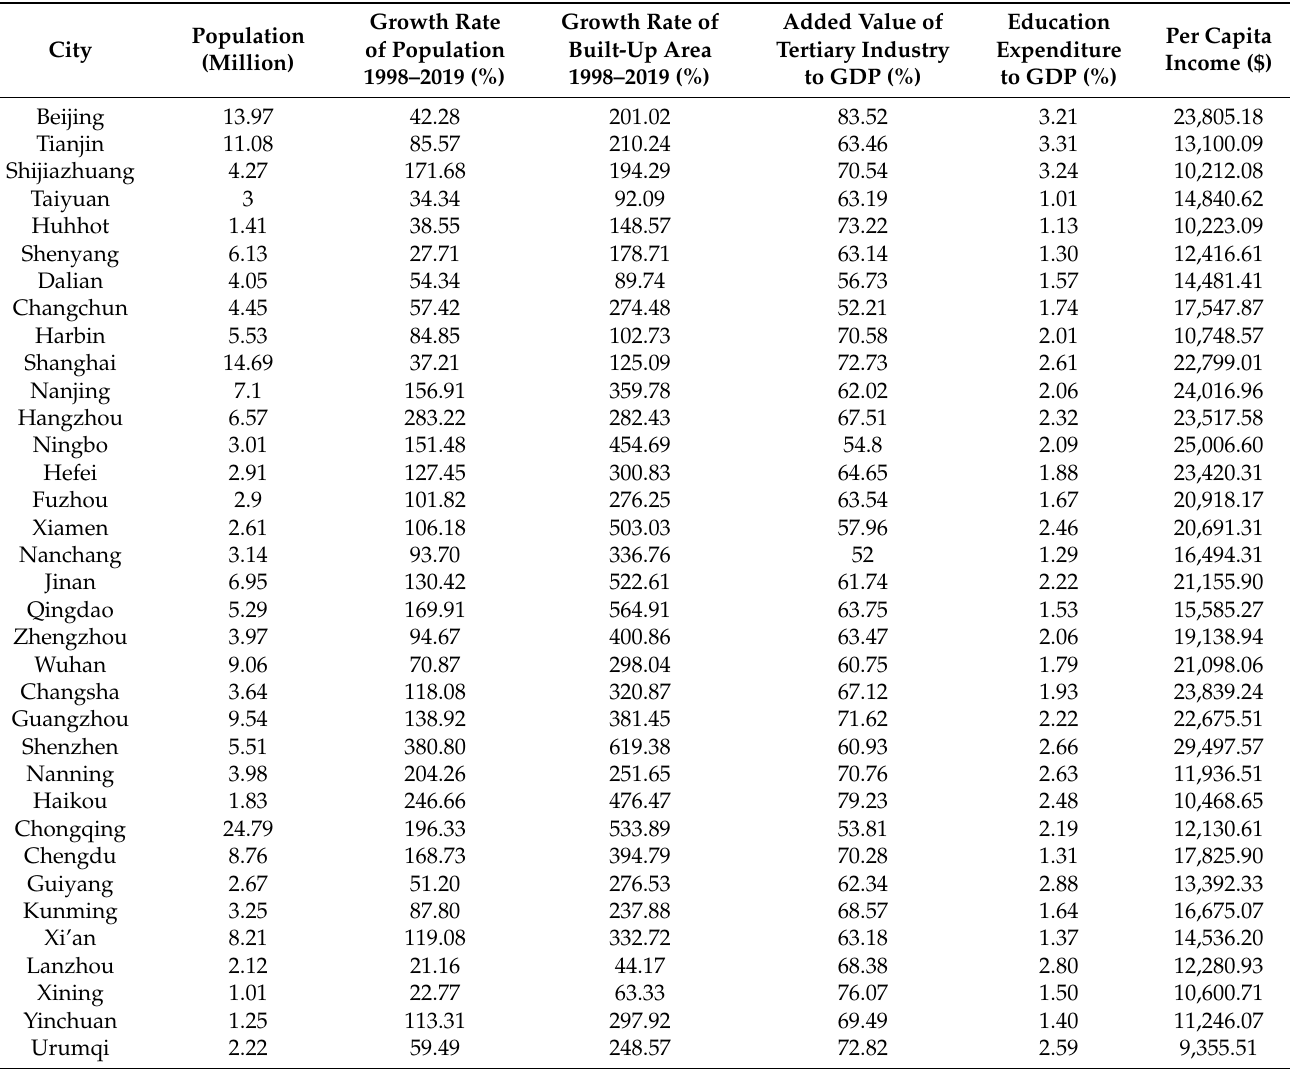
Table 1. City names and major socioeconomic conditions in 2019.